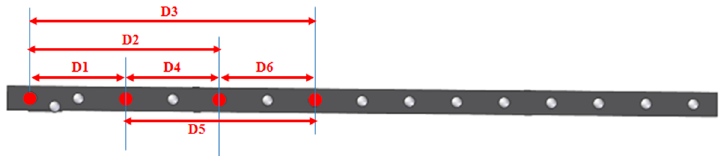
Figure 3. Distances between spheres centers in the gauge, position Diag45 upwards.